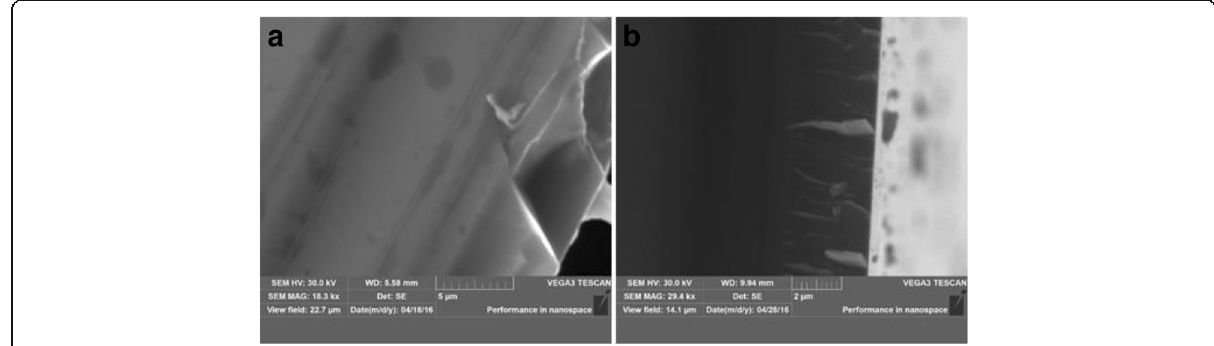
Fig. 2 The cross-sectional images of ZnO films deposited at the different substrate temperatures T s : a 200 °C; b 300 °C